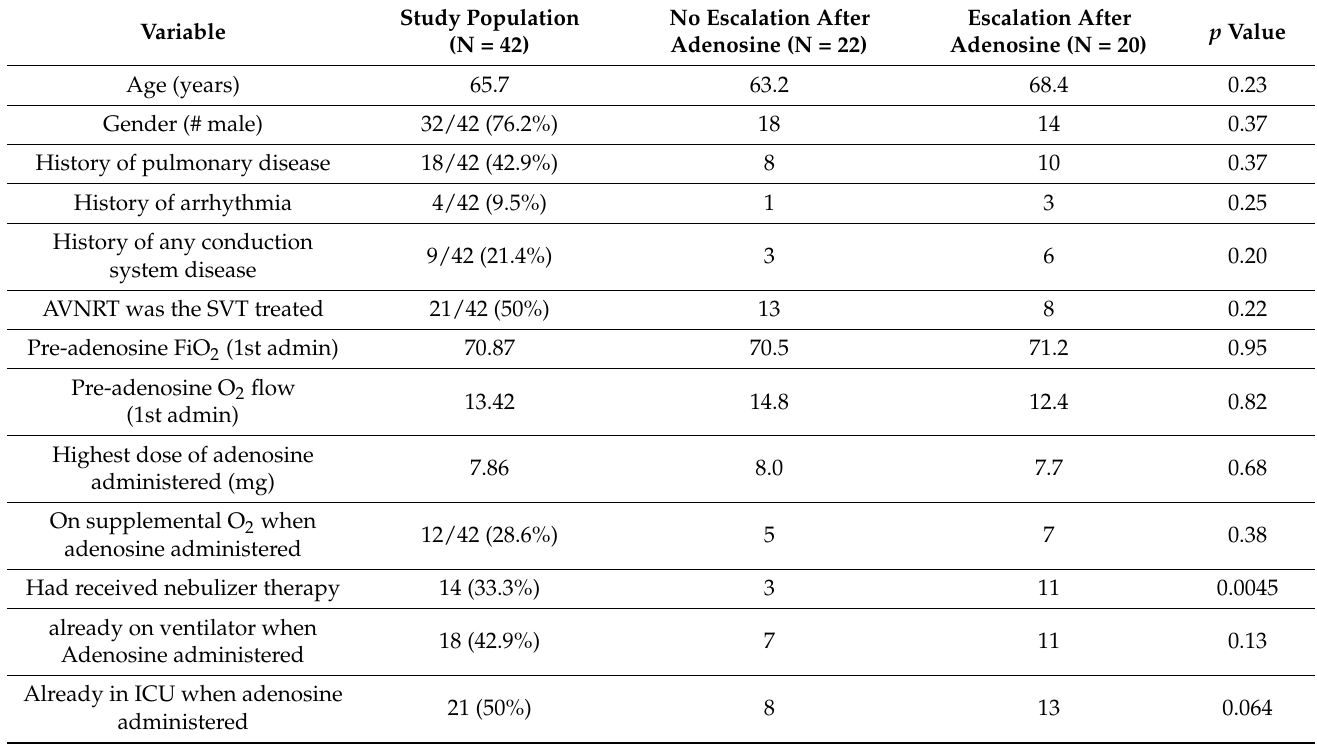
Table 2. Study group. Clinical variables are shown for all study group patients, and also separately for patients who did not and did require escalation of